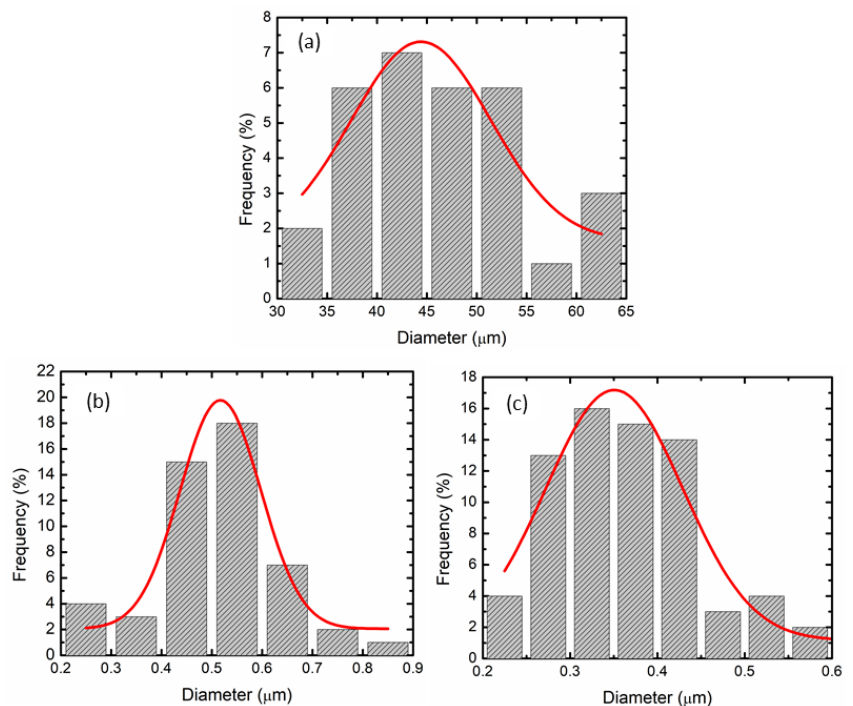
Figure 7. The particle size distribution of ( a ) commercial LiAlH 4 , ( b ) as-milled LiAlH 4 and ( c ) LiAlH 4 + 10 wt.% CoTiO 3 .